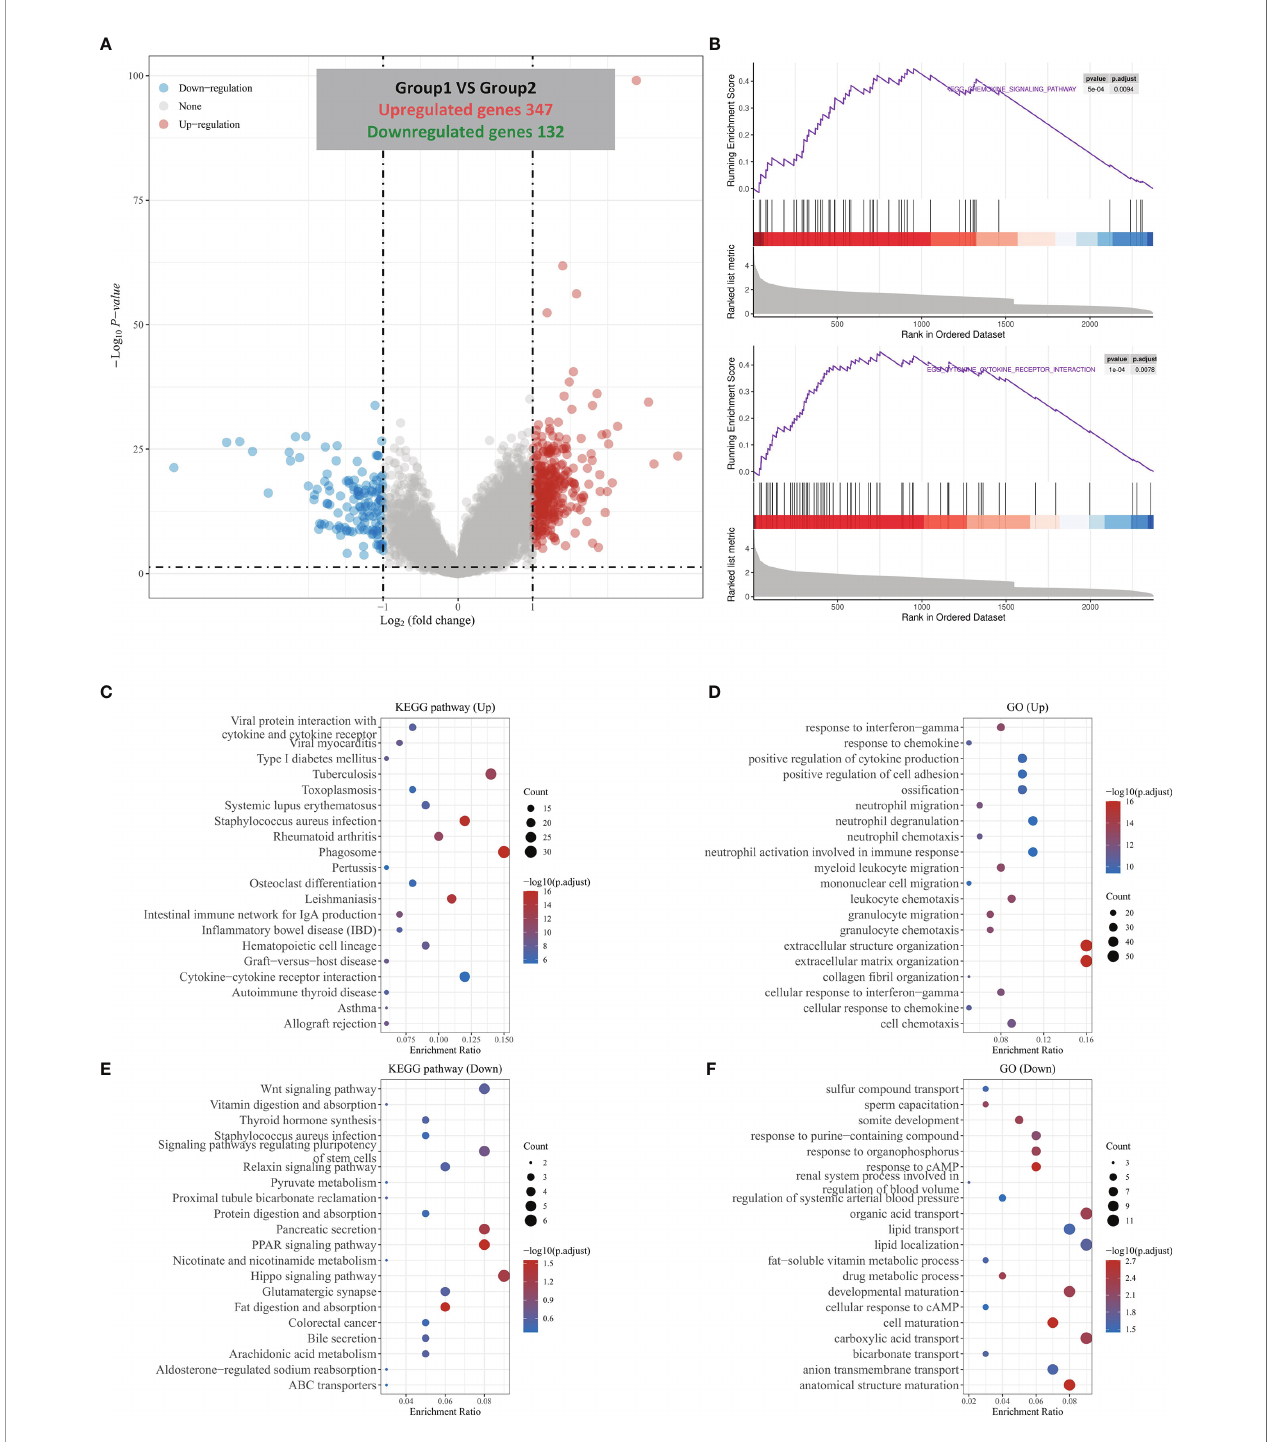
FIGURE 3 | DEGs divided by HOXC6 expression and GSEA, KEGG, and GO analysis of these DEGs. (A) A total of 347 upregulated genes and 132 downregulated genes were identi fi ed in the HOXC6 high-expression group compared to the low-expression group. (B) GSEA revealed that the cytokine interaction pathway and chemokine signaling pathway were signi fi cantly enriched in DEGs by HOXC6 upregulation. (C) KEGG pathway analysis for 347 upregulated DEGs. (D) GO analysis for 347 upregulated DEGs. (E) KEGG pathway analysis for 132 downregulated DEGs. (F) GO analysis for 132 downregulated